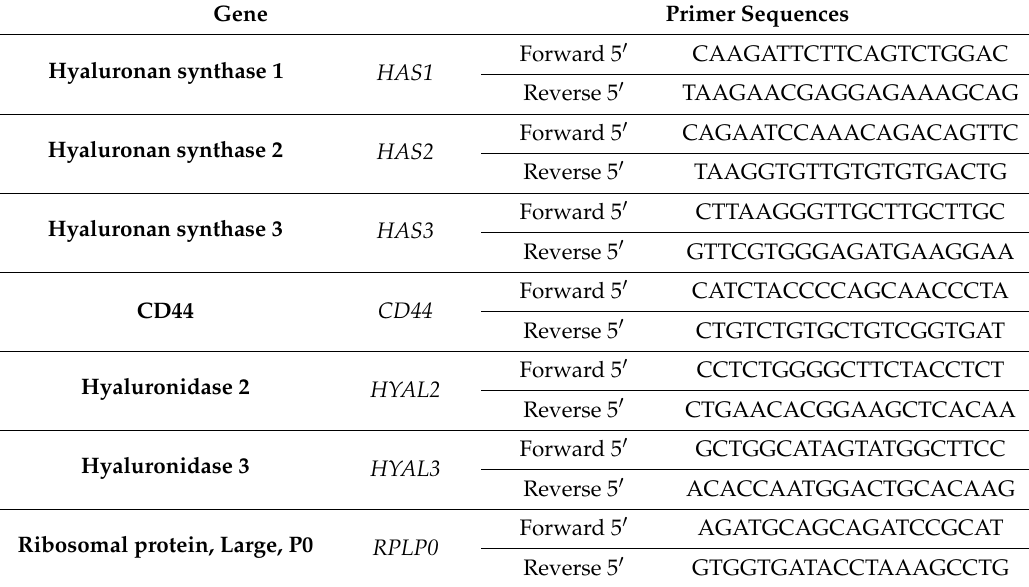
Table 1. Quantitative real-time RT-PCR primer